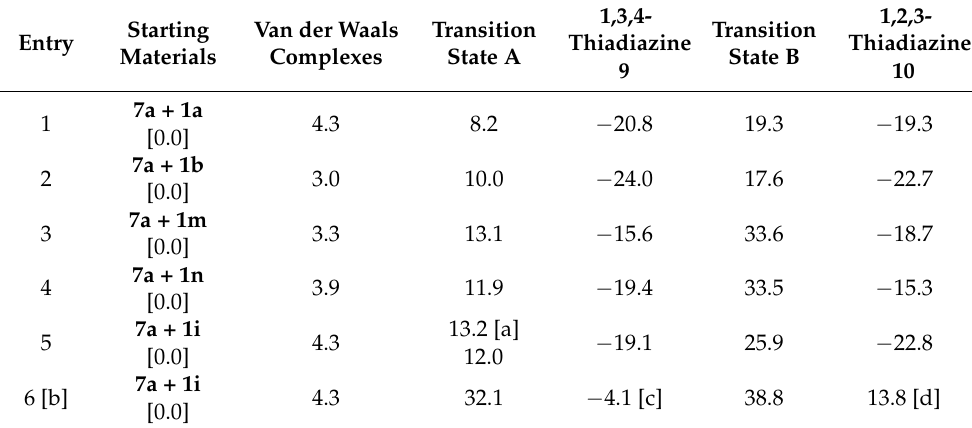
Figure 5. Transition states of the two-step cycloaddition of azoalkene 7a with 3-thioxocyclobuta- none derivative 1i ; left side: TS A1 leading to zwitterion Z and TS A2 for the cyclization of Z lead- ing to 1,3,4-thiadiazine derivative 9q .